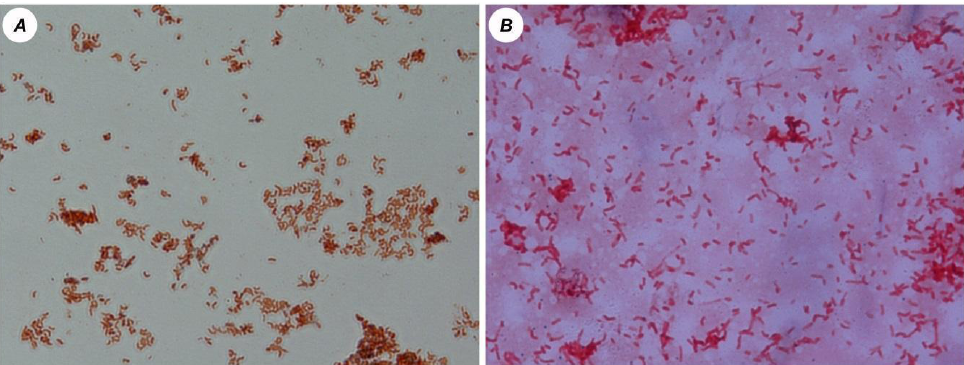
Figure 1. Morphological distributions of sulfate-reducing bacteria (SRB) mixed cultures from healthy people ( A ) and patients with inflammatory bowel diseases (IBDs, B ; magnification × 1000).